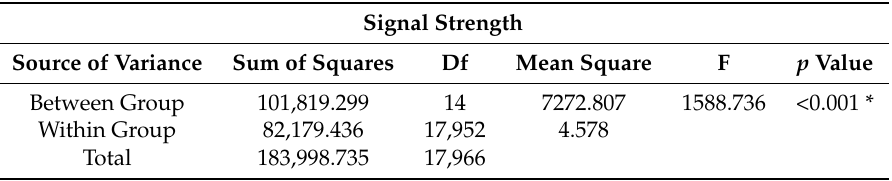
Table A1. One-way variance